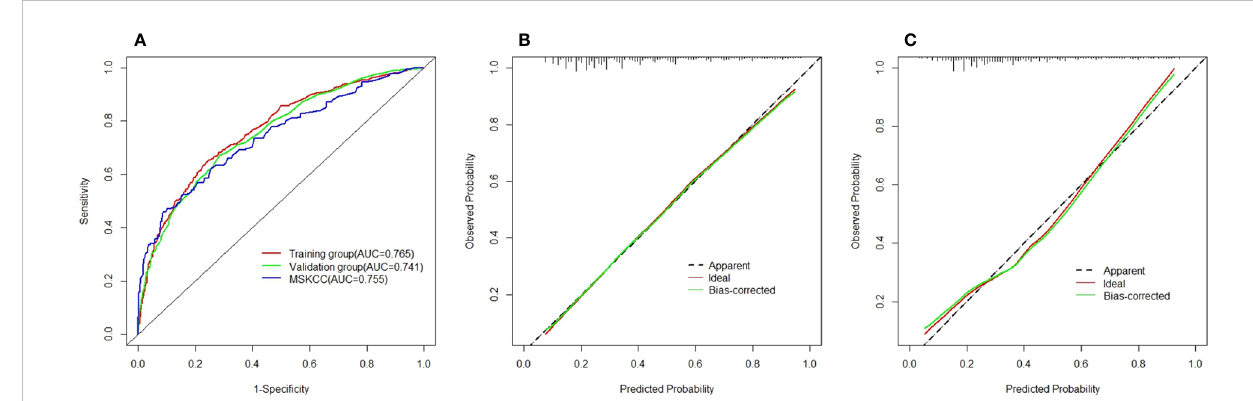
FIGURE 3 (A) Area under the receiver – operator characteristic curve for the training group (red) and validation group (green) and the Memorial Sloan-Kettering Cancer Center (MSKCC) nomogram (blue). (B) Calibration curves for the nomogram in the training group. (C) Calibration curves for the nomogram in the validation group.